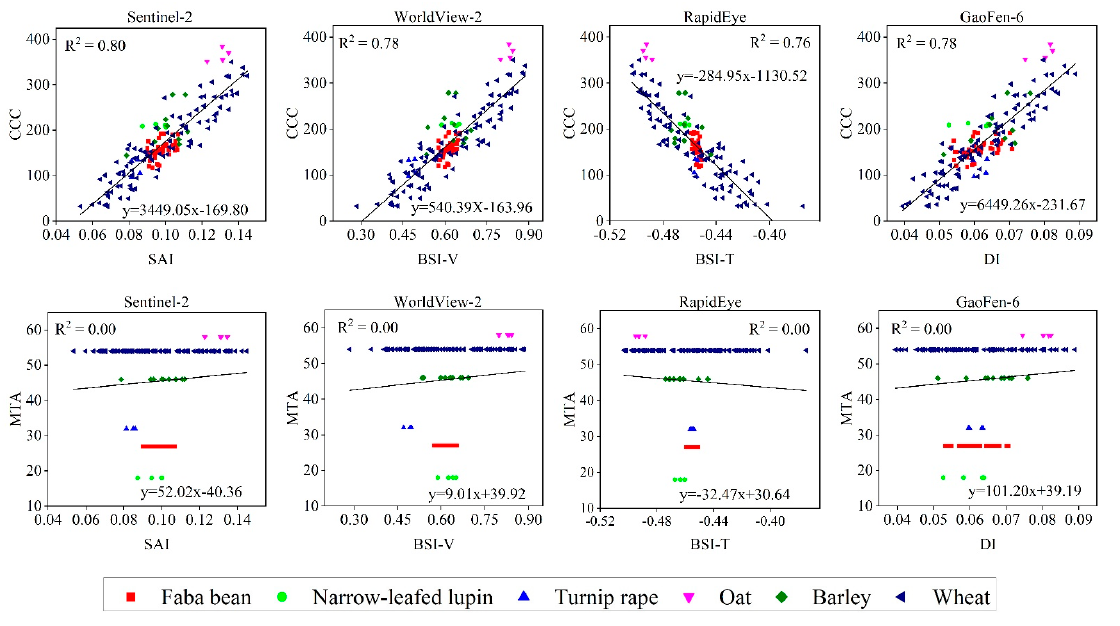
Figure 5. Correlation between the best vegetation indices, and CCC ( top row ) and MTA ( bottom row ) in Sentienl − 2 ( left column ), WorldView − 2 ( second column ), RapidEye ( third column ) and GaoFen ‐ 6 ( right column ) in the field measured dataset.